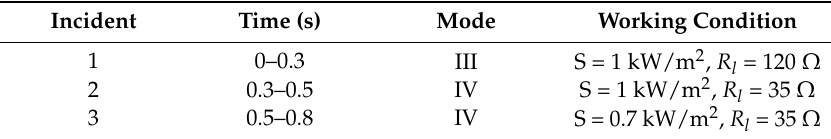
Table 4. Description of simulated working condition